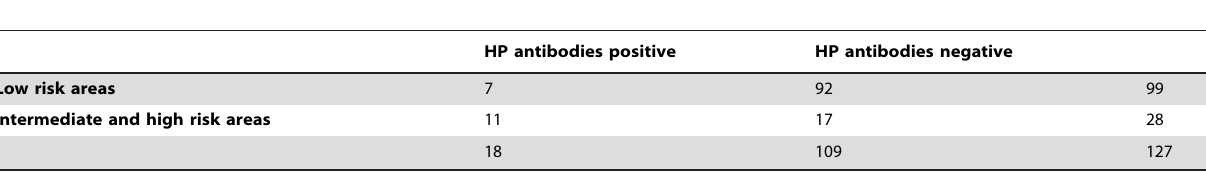
Table 4. The distribution of the study population related to Helicobacter pylori (HP) antibodies and origin from low-, intermediate- or high-risk